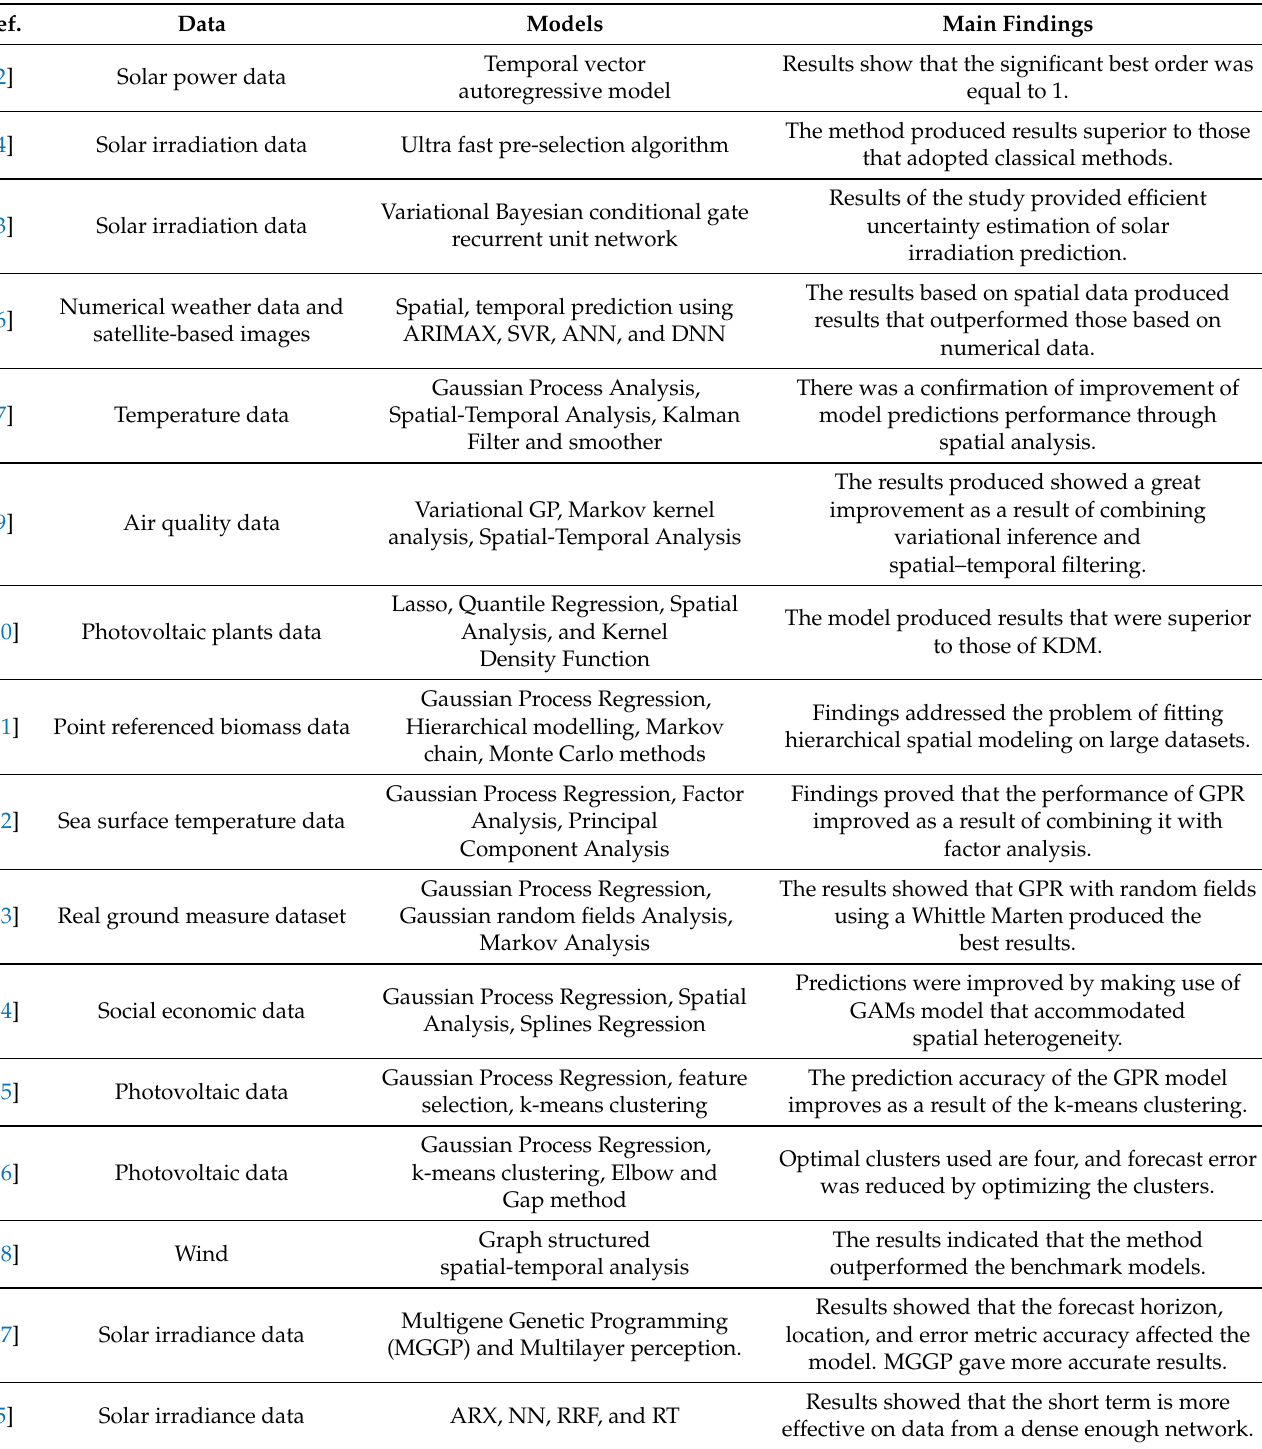
Table 1. Summary of some previous studies on temporal dependence modeling of